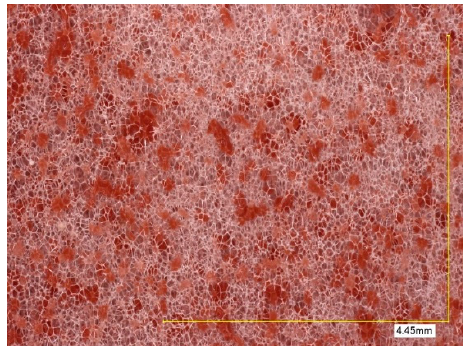
Figure 9. Top side of a melamine sponge treated with CAF 1. Several spots with higher concentration of CAF1 could be observed (stronger red colour).